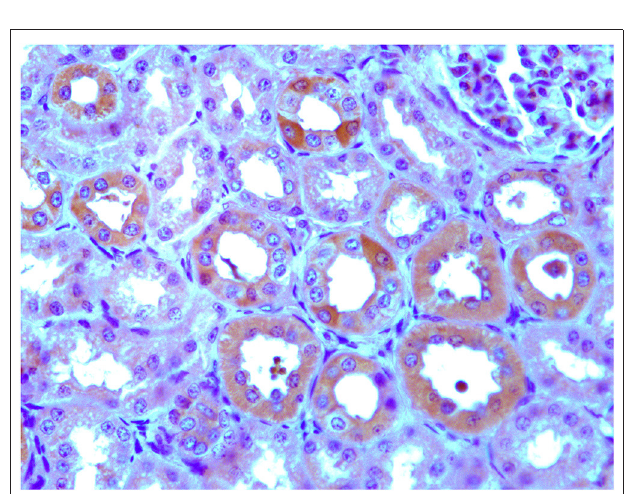
FIGURE 4 | Immunohistochemical evidence of ERAS showing plasmatic and intracytoplasmic localization in epithelial cells of the kidneys and placenta. Inset: No immunoreactivity was seen in renal and placental epithelial cells where the primary anti-ERAS antibody was replaced by appropriate species- and isotype-matched immunoglobulins.